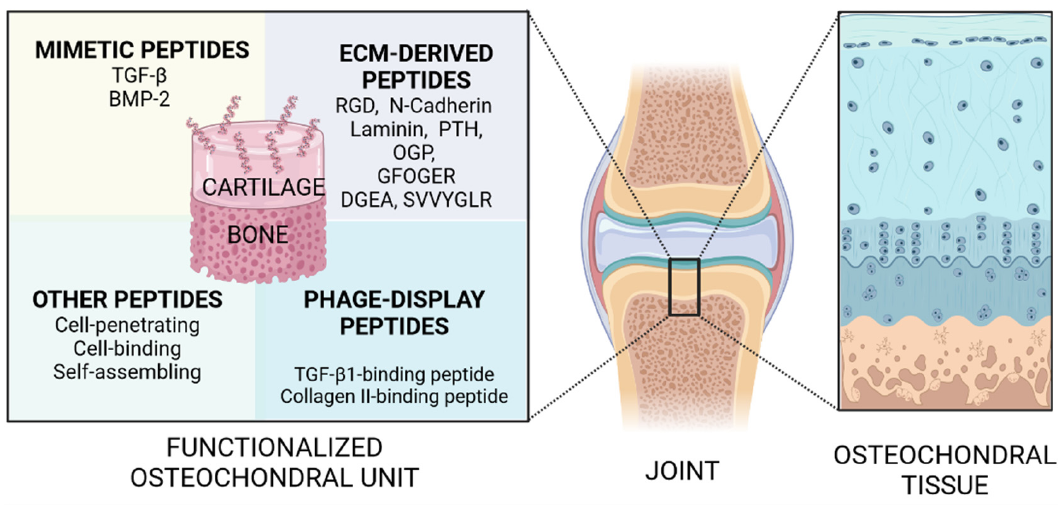
Figure 1. Schematic representation of peptides used in OCTE as a powerful tool to mimic the native osteochondral